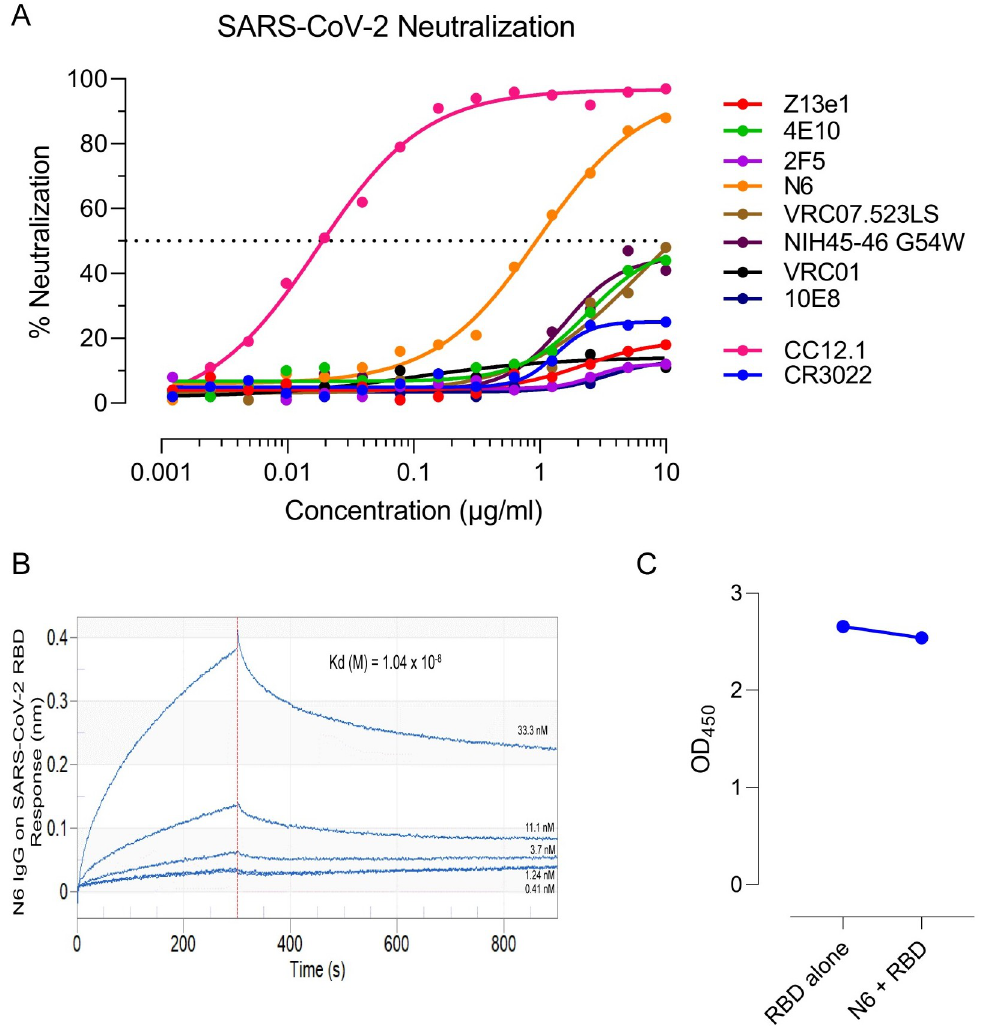
Fig 4. Neutralization of SARS-CoV-2 by HIV-1 bnAbs. (A) The bnAbs were tested for neutralization of pseudotyped SARS-CoV-2 virions. Percent neutralization was calculated by assessing relative luminescence units (RLU) in cell lysates of HEK293T-ACE2 cells 48 hours after infection with SARS-CoV-2 pseudoviruses in the presence of increasing amounts of bnAbs (range, 0.0048 to 10 μ g/ml). N6, an anti-HIV-1 CD4-binding site bnAb, showed cross-neutralization of SARS-CoV- 2. Dotted line corresponds to 50% neutralization. Graphs were plotted using average values (percent neutralization) from three independent experiments. (B) Affinity of N6 against SARS-CoV-2 RBD was measured using biolayer interferometry. (C) Competition ELISA was performed for RBD binding to ACE2 in presence and absence of N6. Average OD 450 value from three independent experiments are shown. CR3022, a SARS-CoV neutralizing antibody, and CC12.1, a SARS-CoV-2 neutralizing antibody, were used as positive